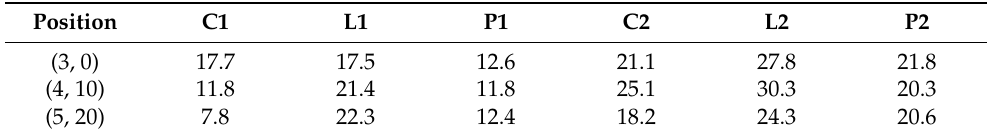
Table 3. Standard deviation of the pixels of inclusions.